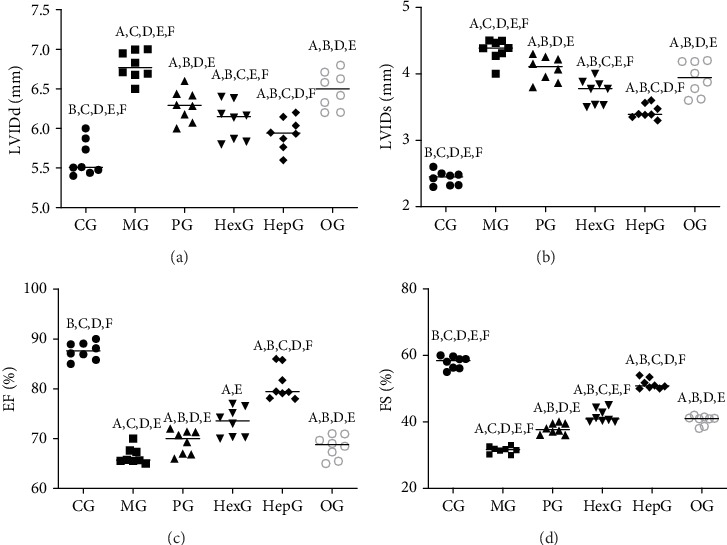
Cardiac function analysis. (a) LVIDd: left ventricular internal diameter in end diastole; (b) LVIDs: left ventricular internal diameter in end systole; EF: ejection fraction; (d) FS: fractional shortening. Ap < 0.05 vs. the CG group, Bp < 0.05 vs. the MG group, Cp < 0.05 vs. the PG group, Dp < 0.05 vs. the HexG group, Ep < 0.05 vs. the HepG group, and Fp < 0.05 vs. the OG group. n = 8 for each group.